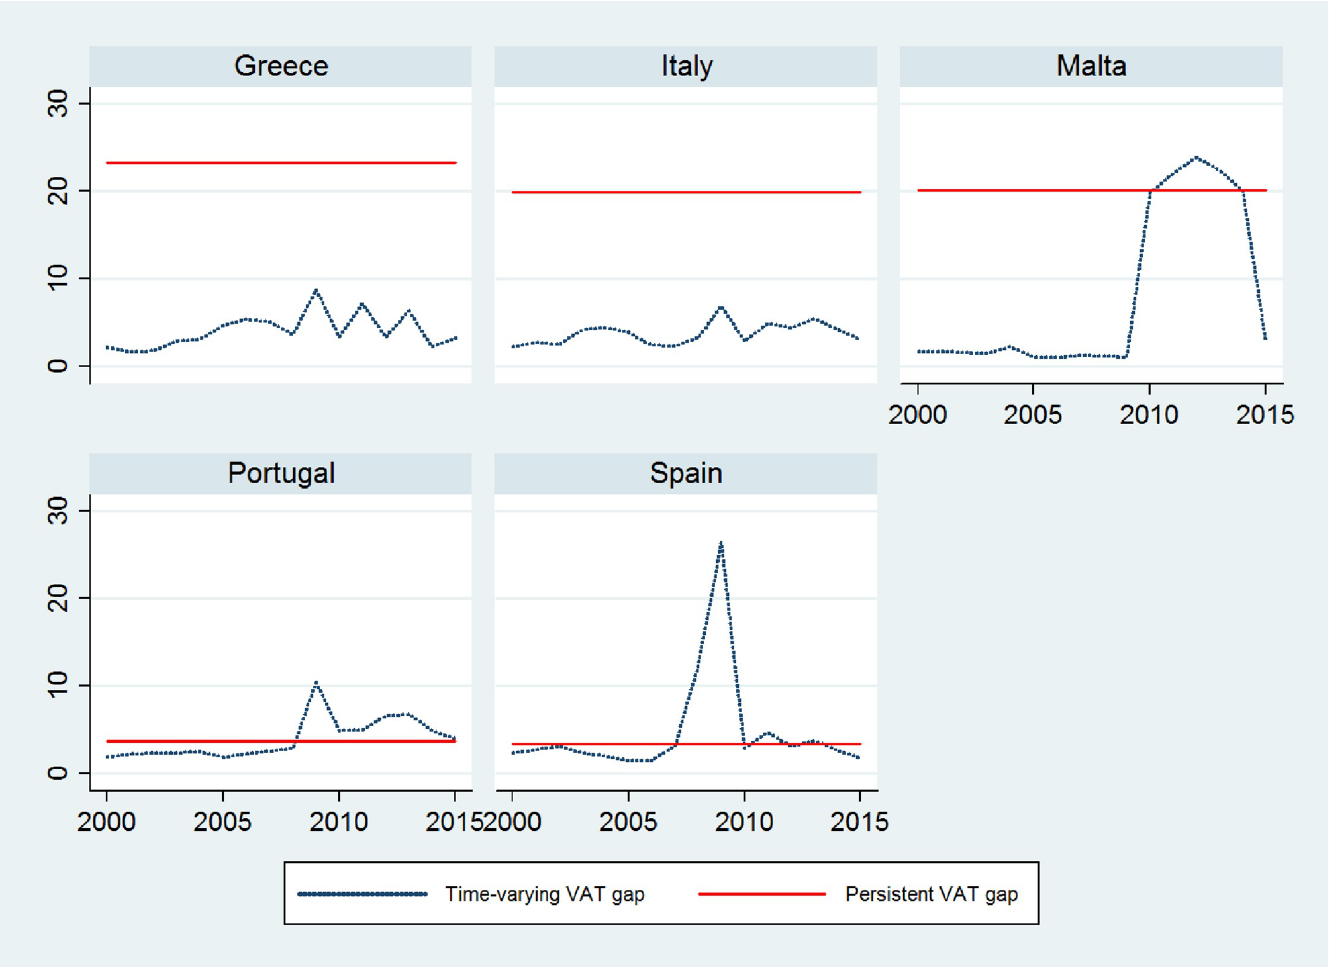
Fig 2. Time-varying VAT gap and persistent VAT gap in the southern group of EU countries. The blue dotted line represents the time-dependent Value Added Tax gap and the red line represents the country-specific or persistent Value Added Tax gap, between 2005–2015. The persistent and time-dependent VAT gap was generated in STATA after the STFM